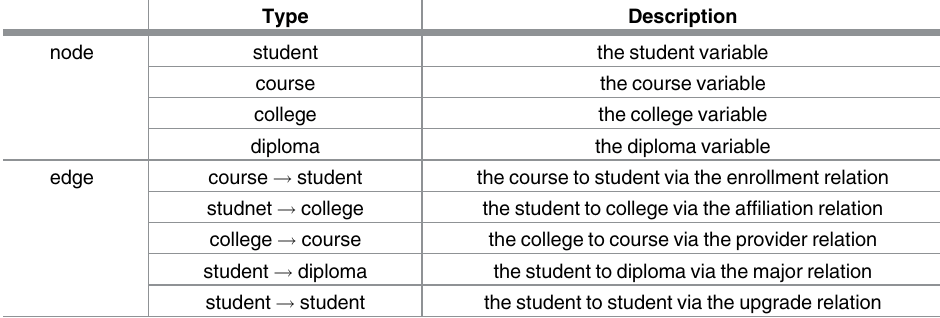
Table 2. Nodes and edges in the contextual